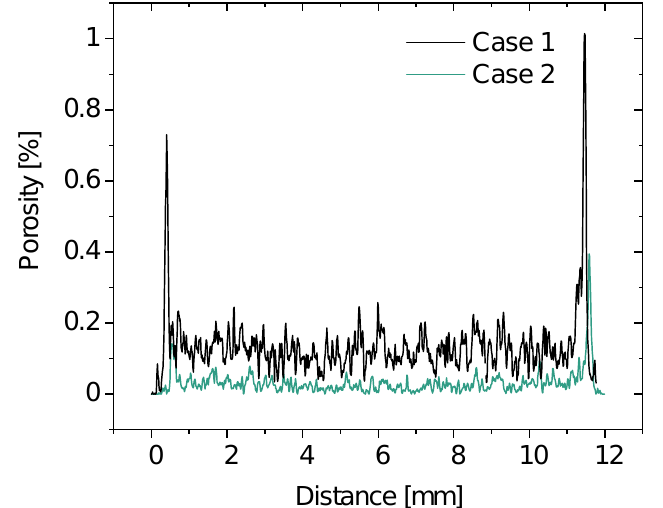
Figure 29. Porosity as a function of the distance to the vertical surface for the manufactured design proposals of optimization case 1 and case